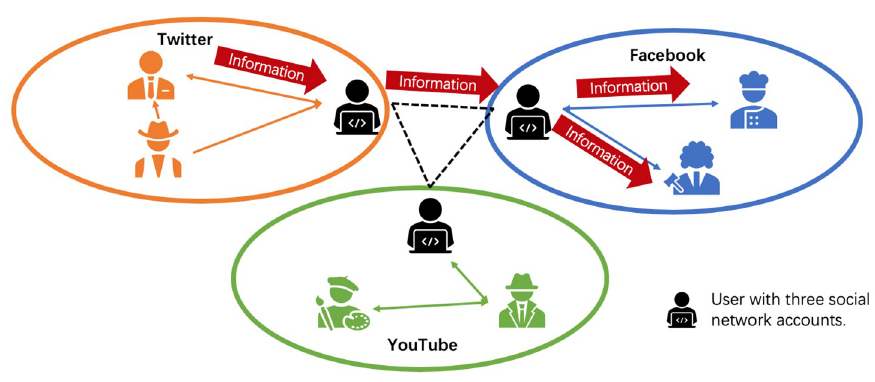
Figure 1. User with multiple accounts forwards information across social networks.